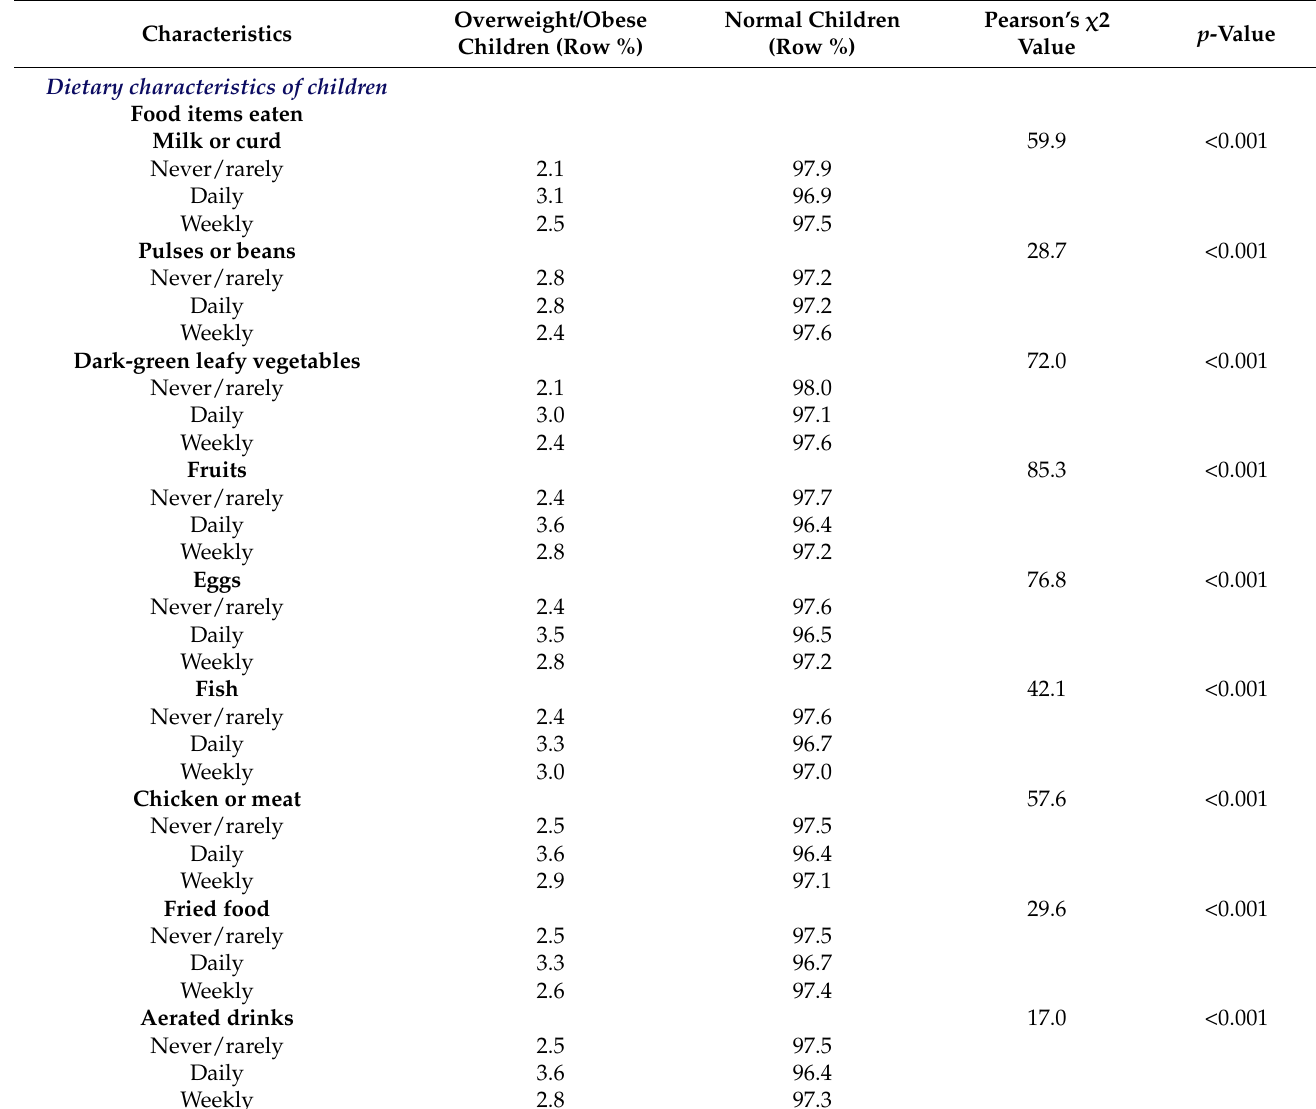
Table 4. Prevalence of overweight/obesity according to dietary characteristics of under-five children in India ( n =